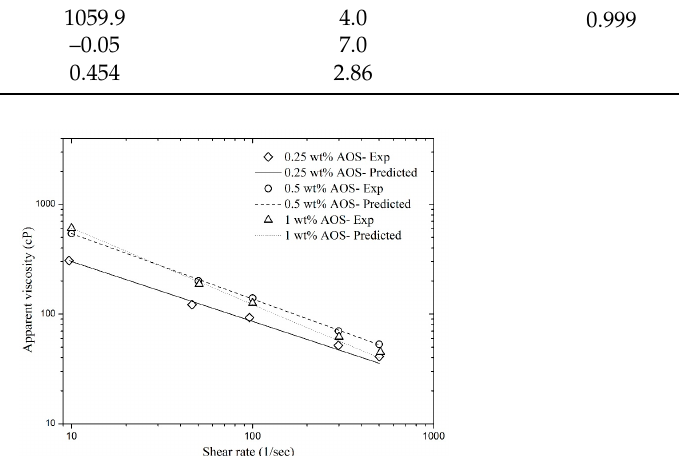
Table 3. Parameter estimates of viscosity correlation Equation (6) for CO 2 foam as a function of temperature and shear rate.